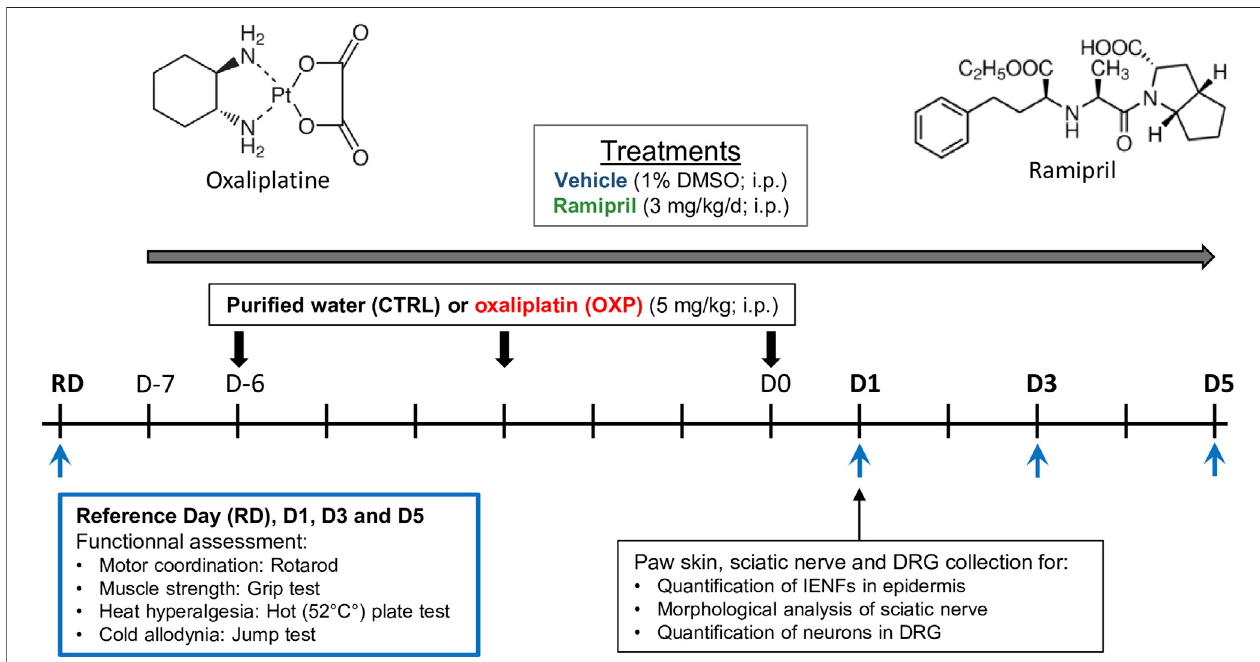
FIGURE 1 | Schematic representation of the study design. CTRL, control; D, day; DMSO, diméthylsulfoxyde, DRG, dorsal root ganglion; IENFs, intraepidermal nerve fi bers; i.p., intraperitoneal; RD, reference